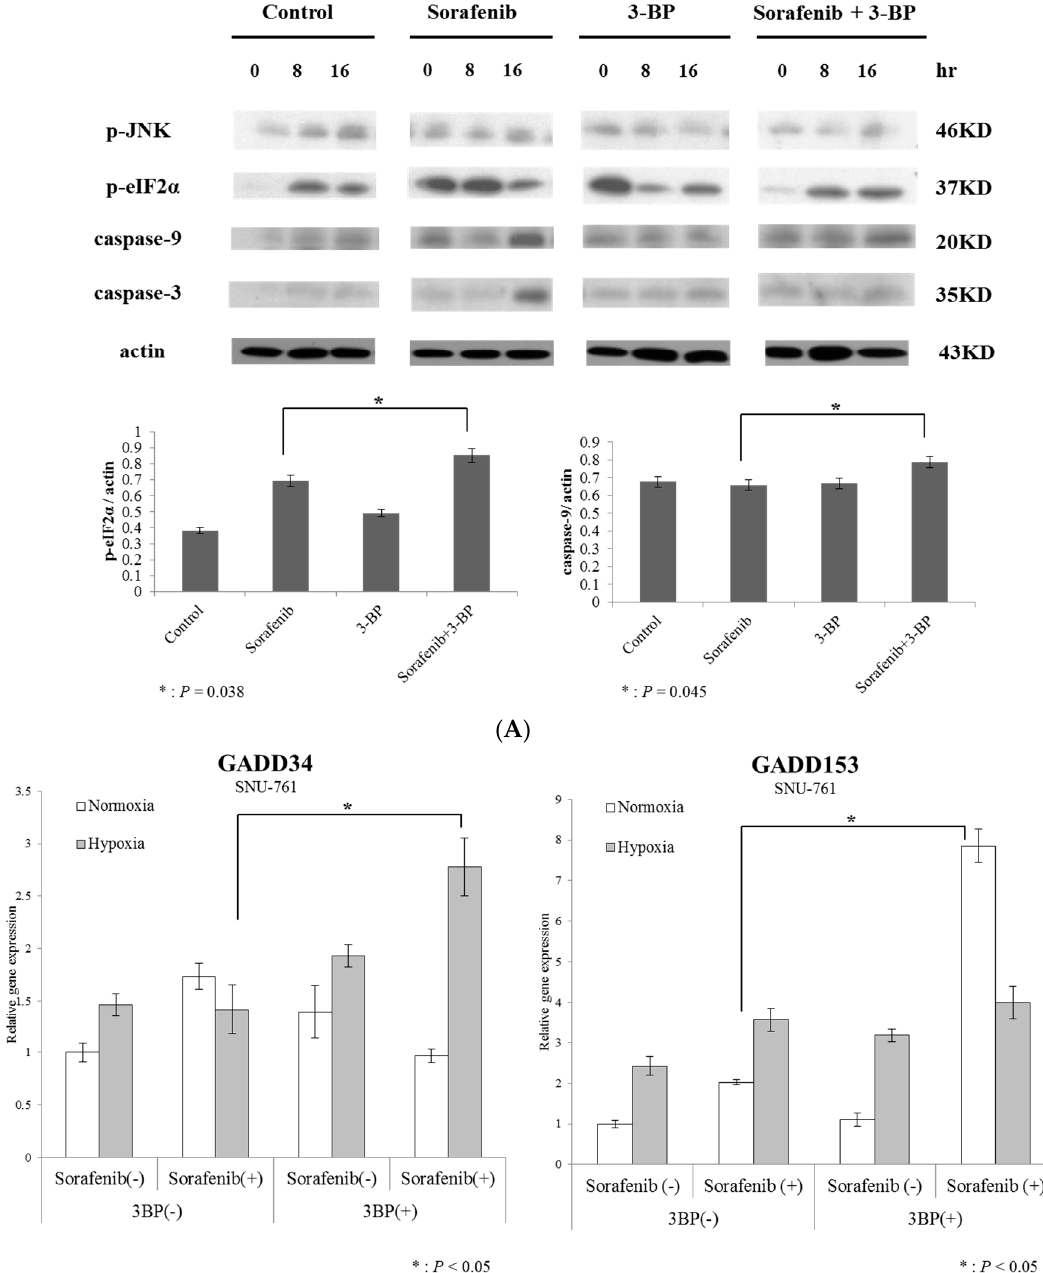
Figure 3. Inhibition of HK-II by 3-BP reverses increased ER stress and sorafenib resistance.The SNU-761 cells were serum starved for 16 h and then treated with sorafenib (8 µ M) in the presence or absence of 3-BP (75 µ M). ( A ) Equivalent amounts of proteins were immunoblotted using anti-phospho-JNK, anti-phospho-eIF2 α , anti-caspase-9, anti-caspase-3, and anti-actin antibodies. ( B ) The ER stress markers, GADD34 and GADD153 , were evaluated by quantitative real-time PCR ( n = 3, Mann-Whitney test t -test, * p <